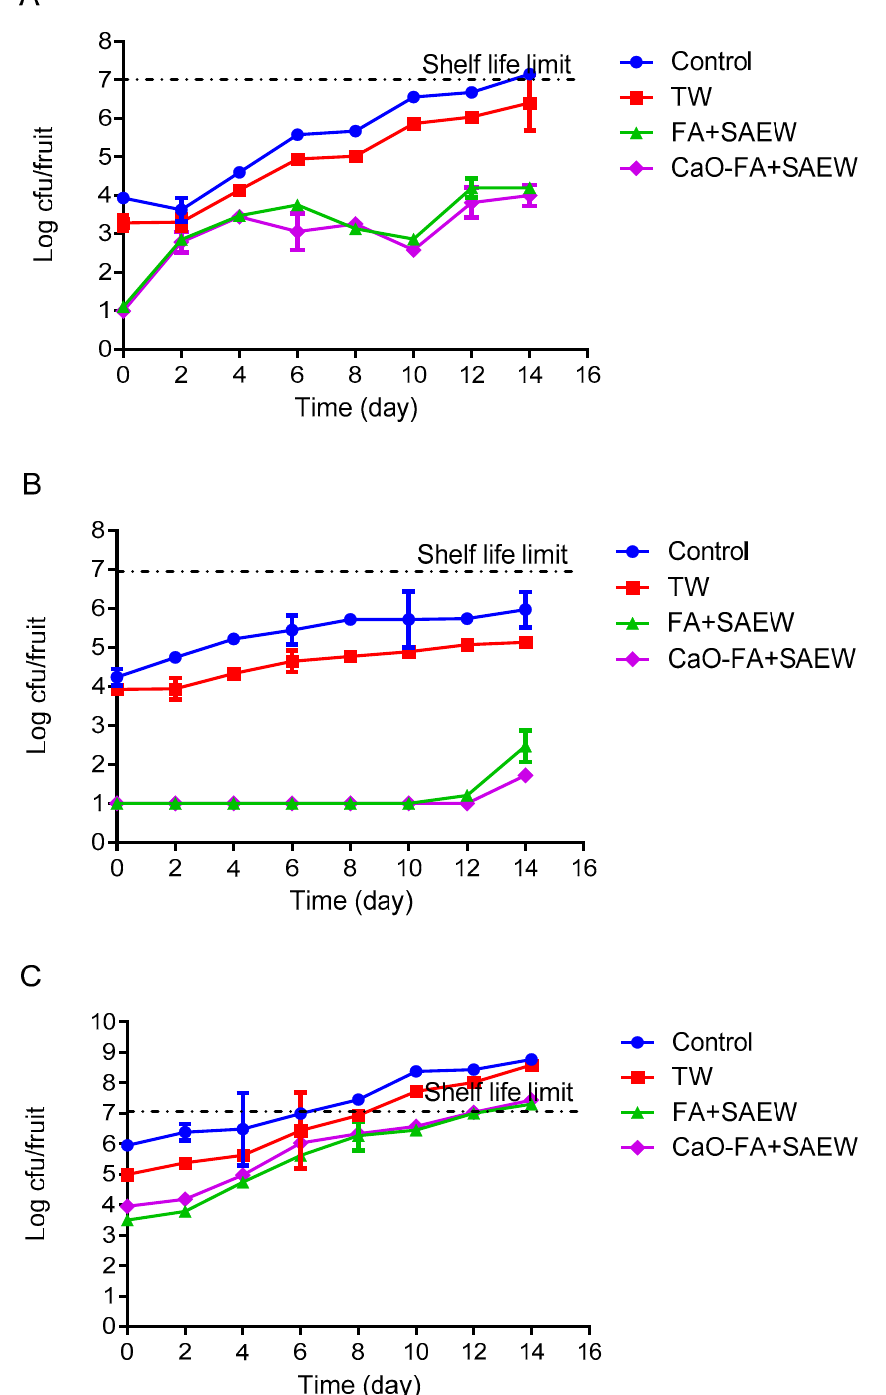
Figure 4. The growth of total coliforms on fruits during storage at 4 °C after different treatments. TW: Tap water; FA+SAEW: Combination of FA and SAEW treatment; CaO–FA+SAEW: Calcium oxide washing followed by combination of FA+SAEW treatment. Red line represents the end of shelf-life. ( A ) Apple; ( B ) mandarin; ( C ) tomato. Vertical bars represent standard error of the mean ( n = 3).